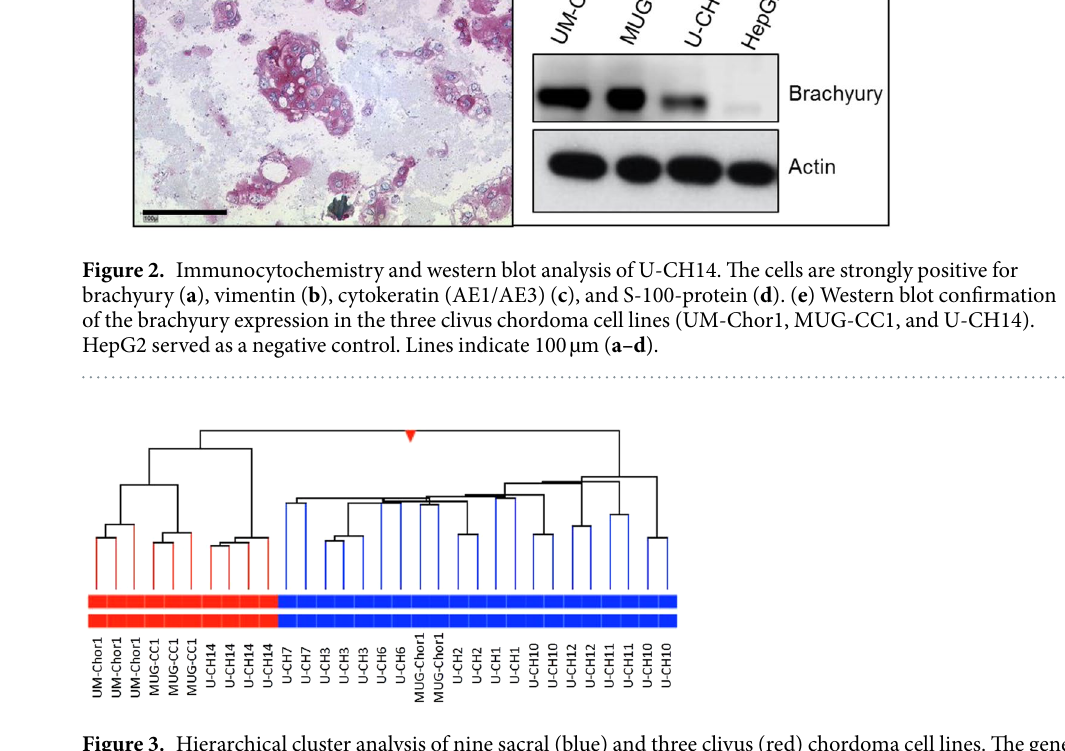
Figure 3. Hierarchical cluster analysis of nine sacral (blue) and three clivus (red) chordoma cell lines. The gene expression was tested using the 4 × 44 K whole genome microarray (Agilent Technologies). Each cell line was tested at least in